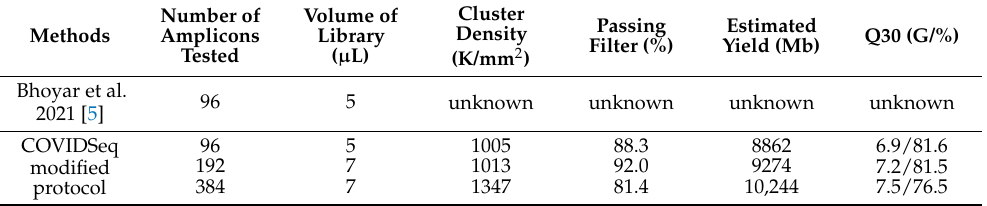
Table 1. Different protocols of library preparation to sequence amplicons using modified